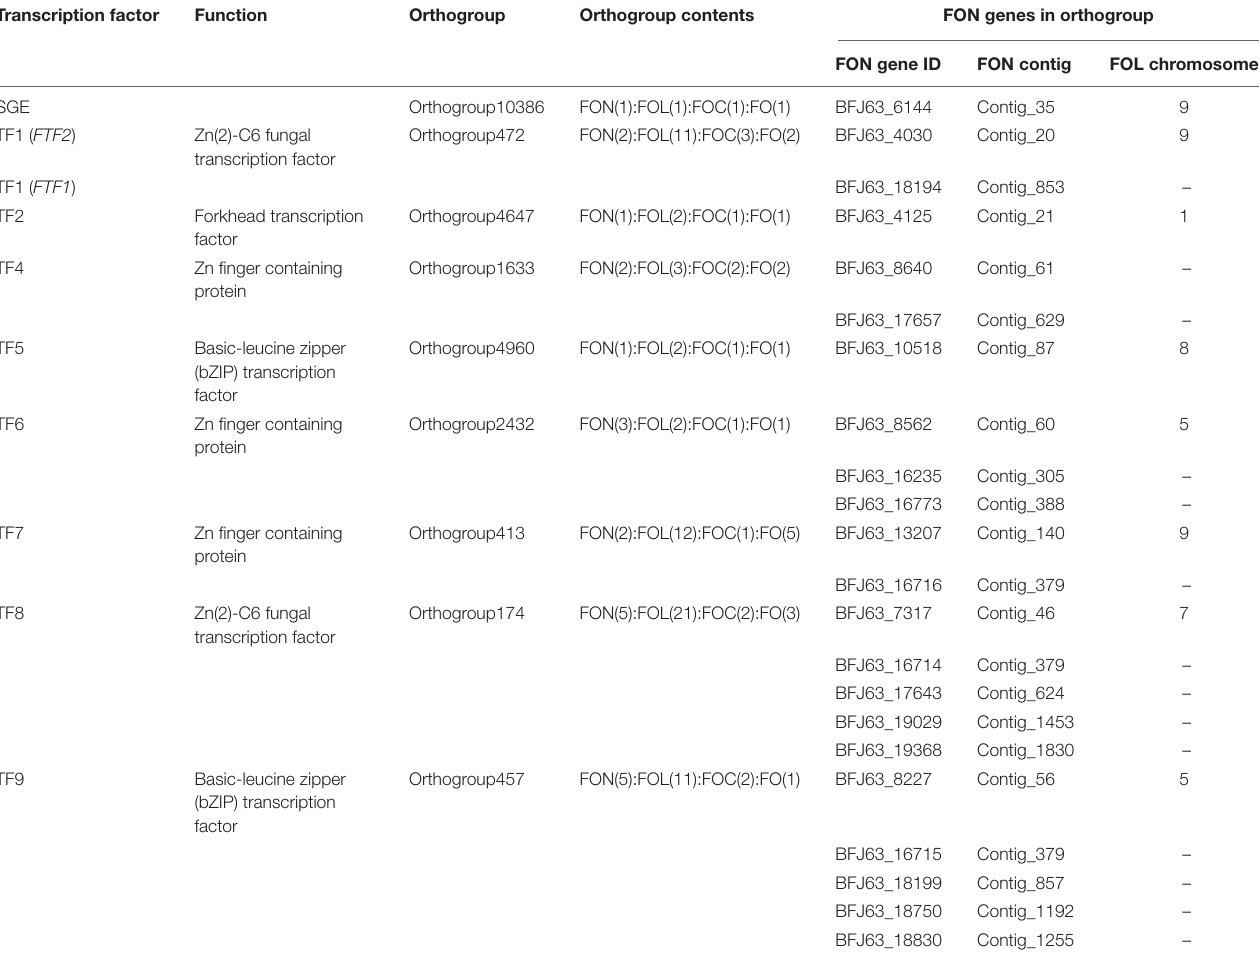
TABLE 4 | Members of SGE and TF1-9 transcription factor families in FON. Transcription